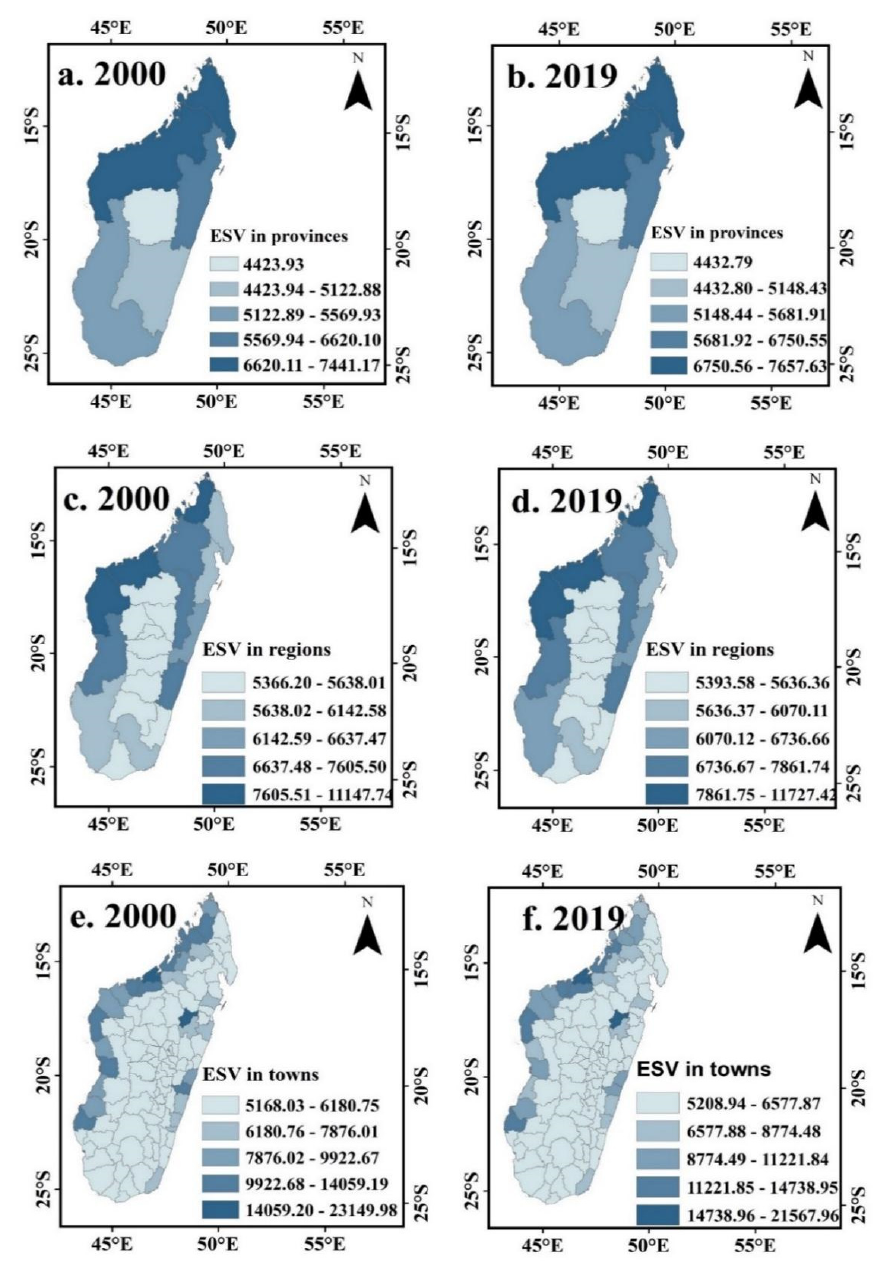
Figure 3. Spatial pattern of change in the rate of ecosystem services value for the provinces ( a , b ), the regions ( c , d ), and towns ( e , f ) in Madagascar island from 2000 to 2019.